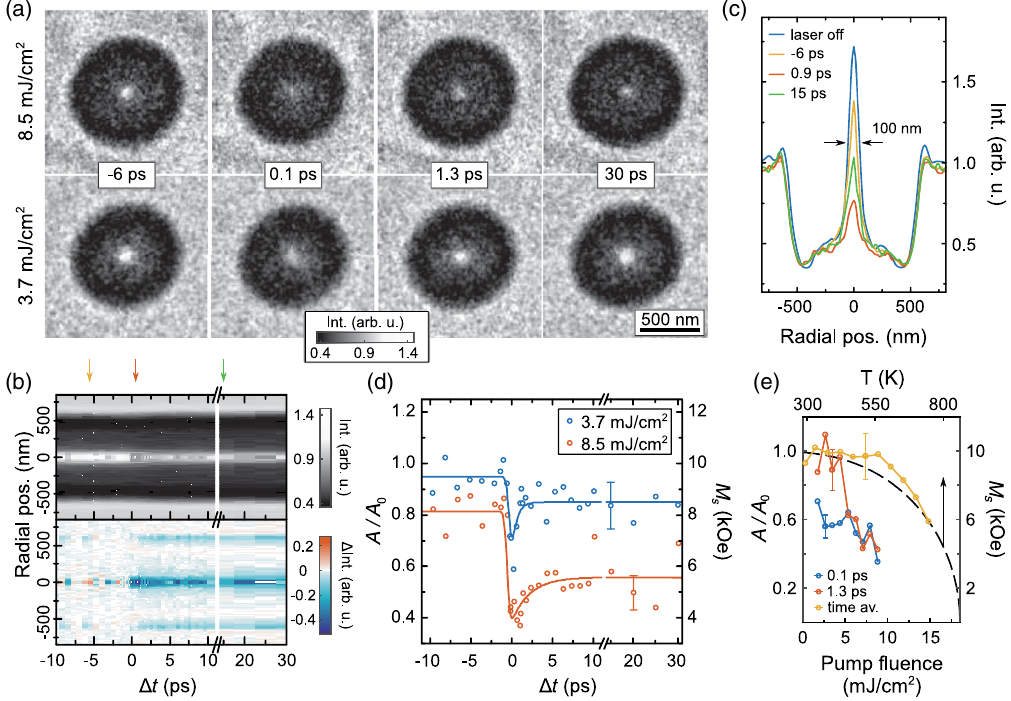
FIG. 2. Delay-time-dependent Lorentz contrast of a single, optically excited magnetic disc. (a) Time-resolved Lorentz micrographs for pump fluences of 8.5 (top row) and 3 . 7 mJ = cm 2 (bottom row). (b) Temporal evolution of azimuthally averaged intensity profiles of the micrographs for a pump fluence of 8 . 5 mJ = cm 2 (top row). In the bottom row, the mean profile before the arrival of the pump pulse is subtracted. Profiles for the marked delay times are shown in (c), along with a profile of the unpumped disc. (d) Temporal evolution of the image amplitude A at the disc center (normalized by the amplitude A 0 for the unpumped structure). Solid lines represent the exponential recovery model. (e) The amplitude A as a function of pump fluence from micrographs obtained using a continuous electron beam and electron pulses at specific time delays. The black dashed curve represents Weiss molecular field theory adapted to the